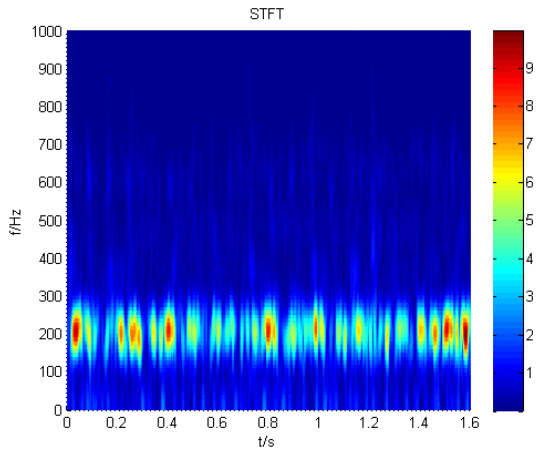
Figure 9. The STFT result acquired from a cracked blade.